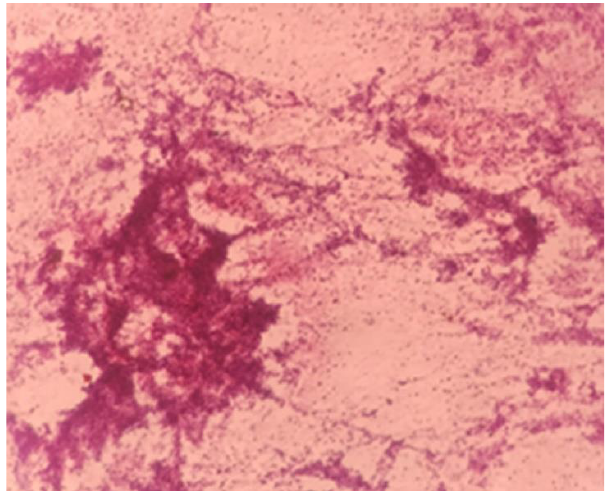
Figure 1 : Cytological Smear (pap stain-100X).